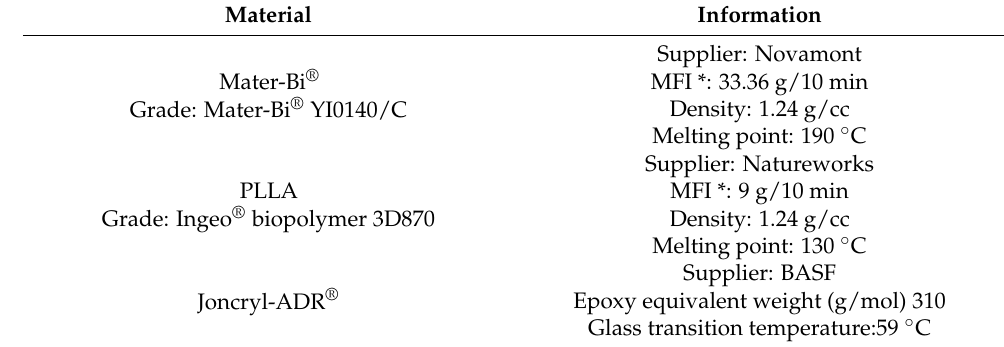
Table 1. Characteristics of the polymers.